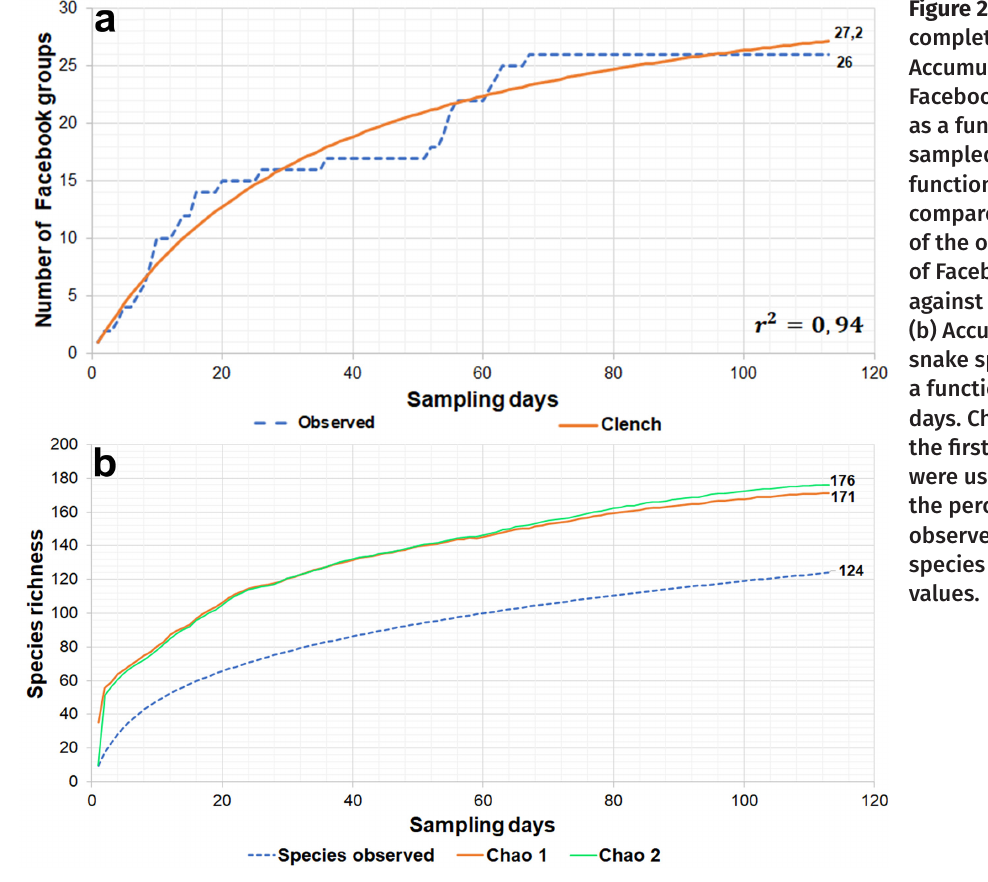
Figure 2. Sample completeness curves. (a): Accumulation curve of Facebook groups